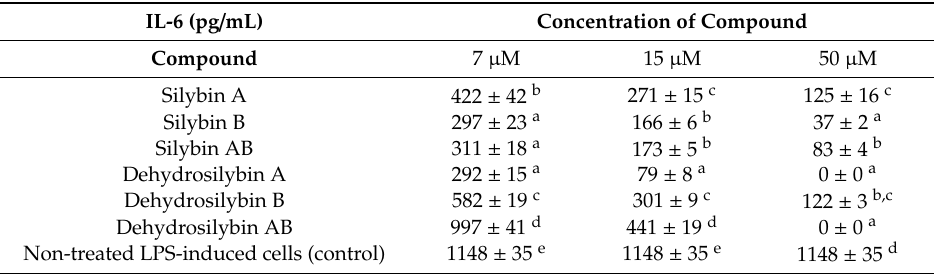
Table 4. The effect of various concentrations of silybins and dehydrosilybins (12.5, 25, 50 µM) on the release of pro-inflammatory cytokine TNF- α by LPS-induced macrophages. Positive control represents the cells challenged with LPS and without pre-treatment of tested compounds. TNF- α (pg/mL)